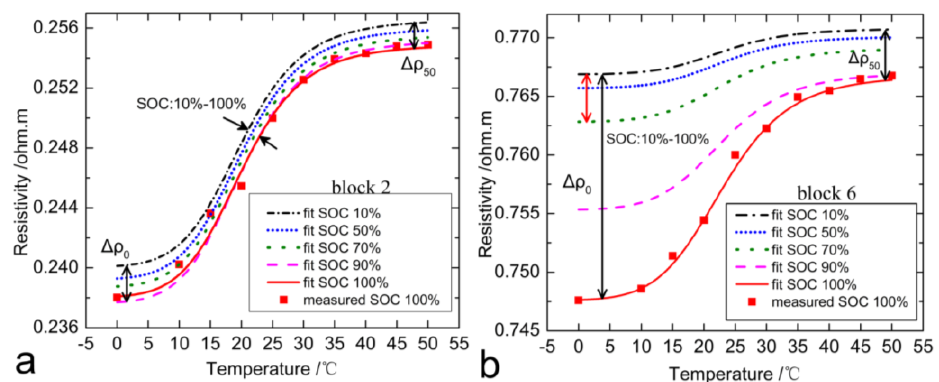
Figure 13. Modified logistical plot of apparent resistivity for a 4.5 Ah battery considering the effect of different SOCs. ( a ) The logistical curves of the block 2; ( b ) the logistical curves of the block 6. The two blocks are chosen in Figure 9 as the reference lines, the other four logistical curves for the two blocks are deduced with different ρ at 10%, 50%, 70%, and 90%